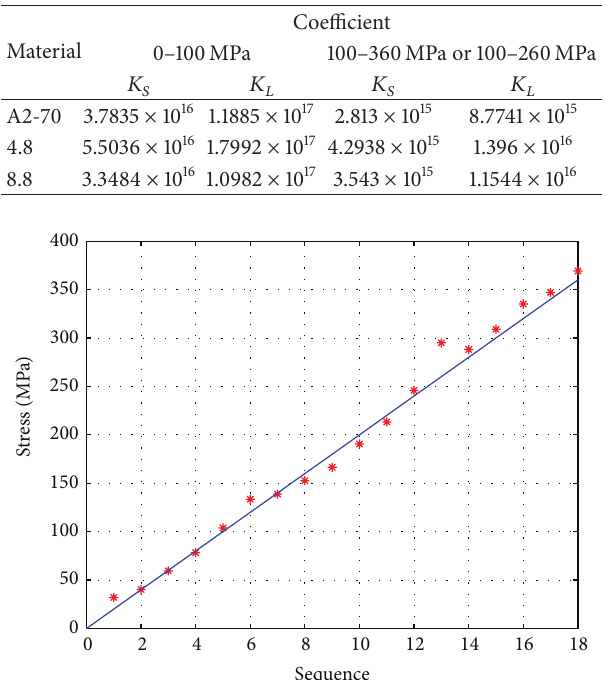
Table 4: Matlab least squares fit of the stress measurement coeffi- cients, 𝐾 𝑆 and 𝐾 𝐿 .